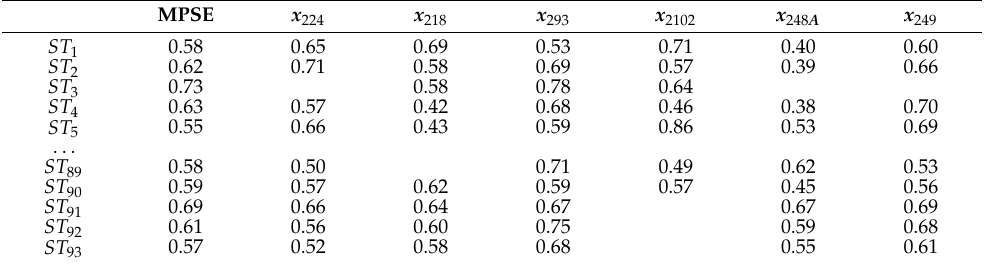
Table 4. Part of the computation results in the statistical time by